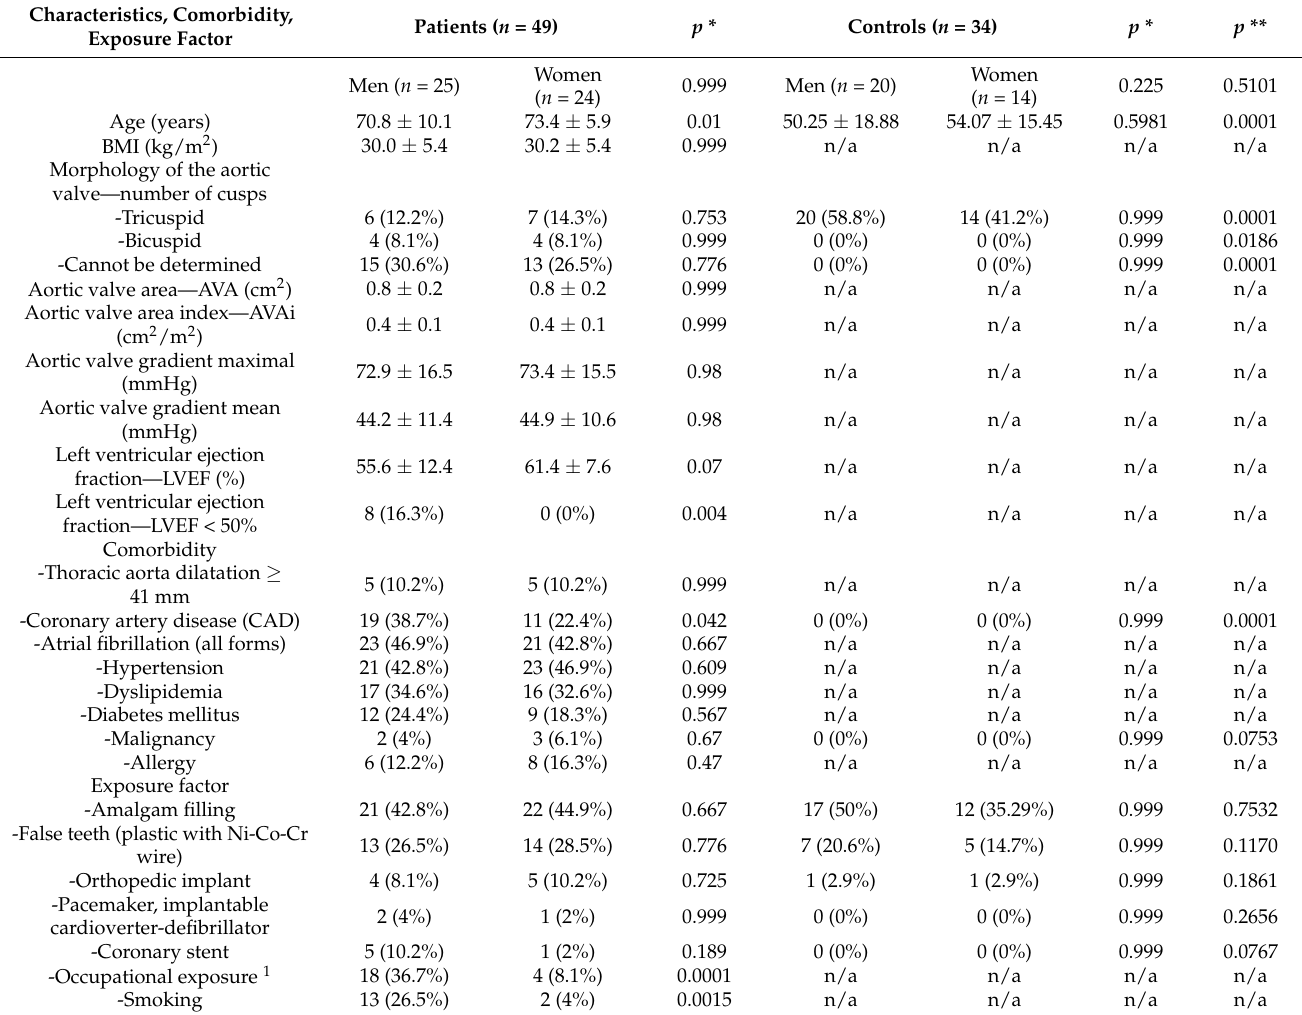
Table 1. The basic characteristics, comorbidities and selected exposure factors in the groups of patients and controls (including the comparison of men and women in both